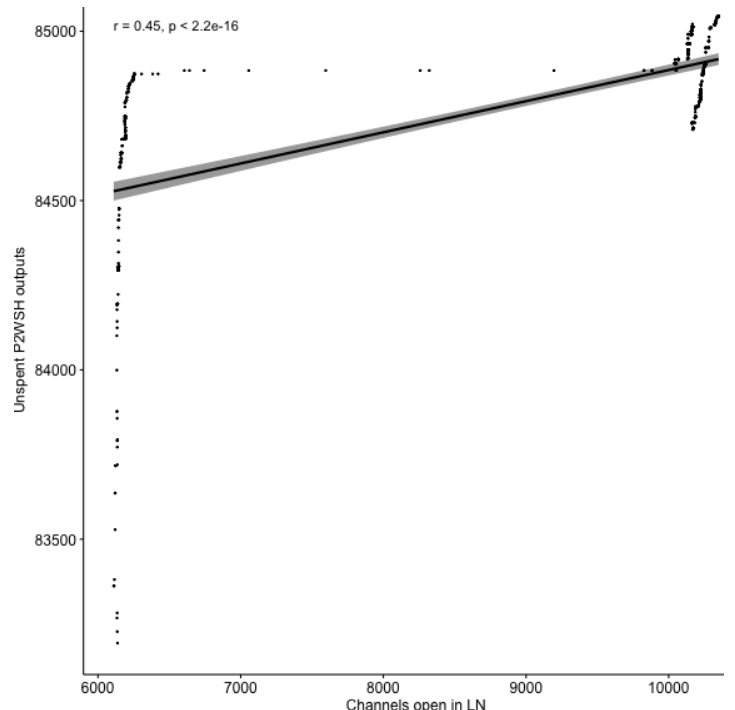
Figure 14. Correlation between unspent P2WSH outputs and LN channels on the